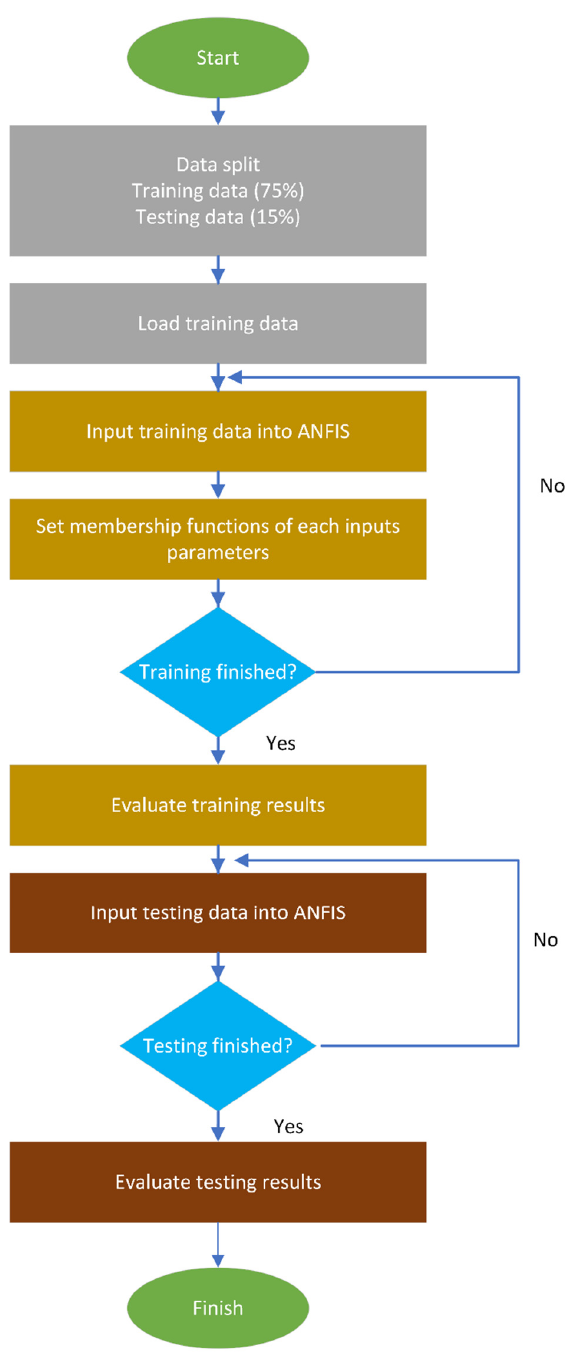
Figure 9. ANFIS flowchart for thermal damage prediction.